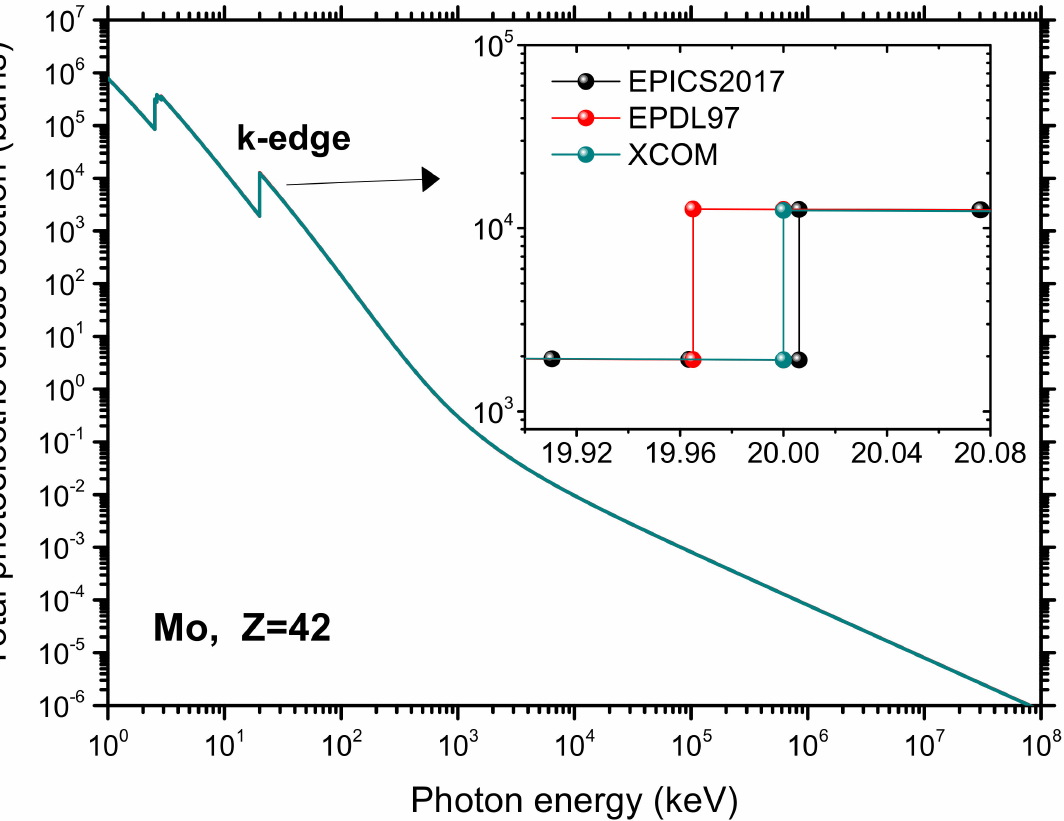
Figure 3. Total photoelectric cross section of molybdenum (Z = 42) element by three different libraries with distinct K-absorption edge